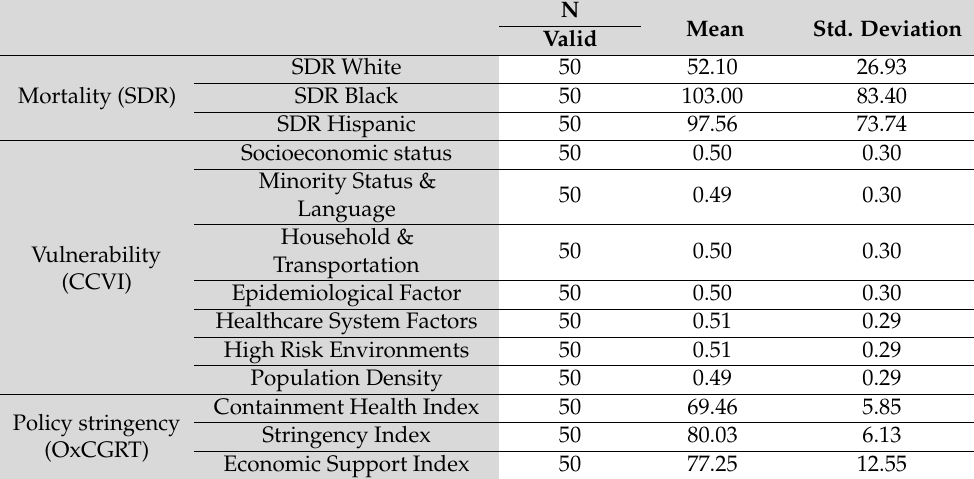
Table 2. Description of the seven categories of the CCVI, the three sub-indices of the OxCGRT and the SDR for each